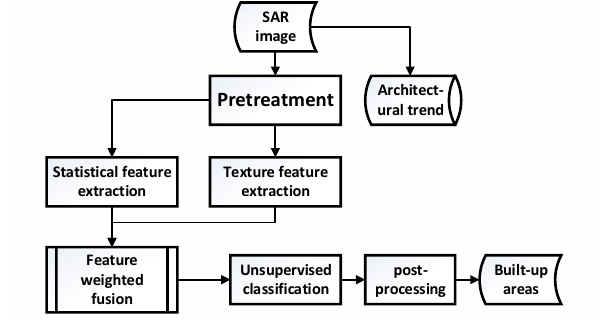
Figure 1 Build-up area extraction process